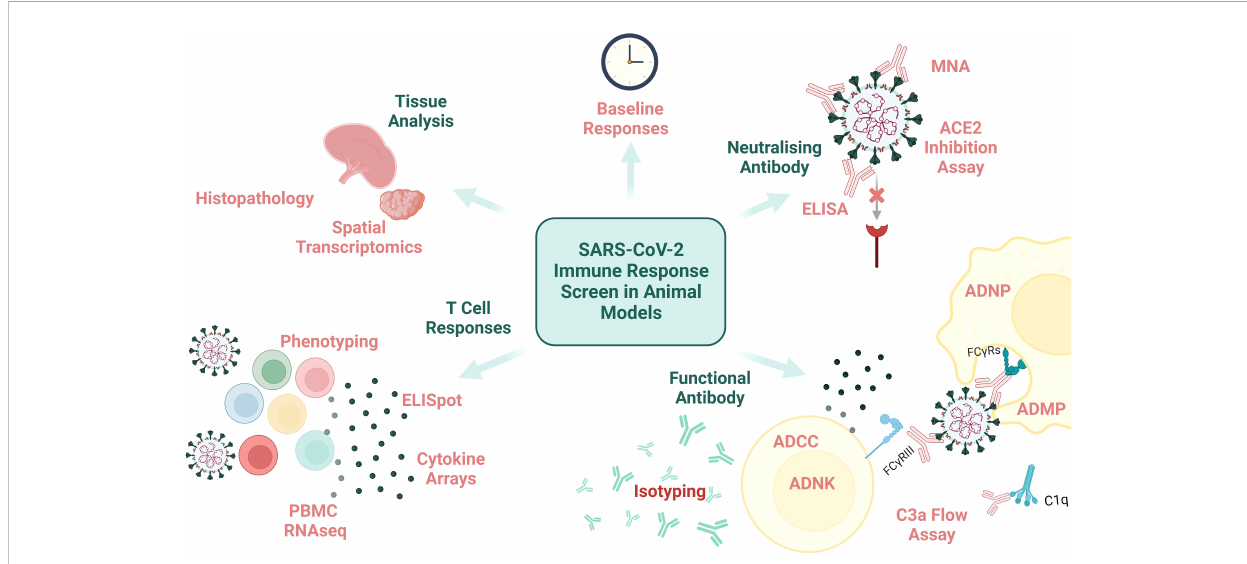
FIGURE 2 An overview of immunological assays and analysis that can be performed on animal samples. MNA, microneutralisation assay; ELISA, enzyme-linked immunosorbent assay; ADNP, antibody-dependent neutrophil phagocytosis; ADMP, antibody-dependent macrophage phagocytosis; FcyRs, fragment crystallisable of antibody receptor; ADCC, antibody-dependent cellular cytotoxicity; ADNK, antibody-dependent NK cell activation; PBMC, peripheral blood mononuclear cells; RNAseq, RNA sequencing. Created with BioRender.com.